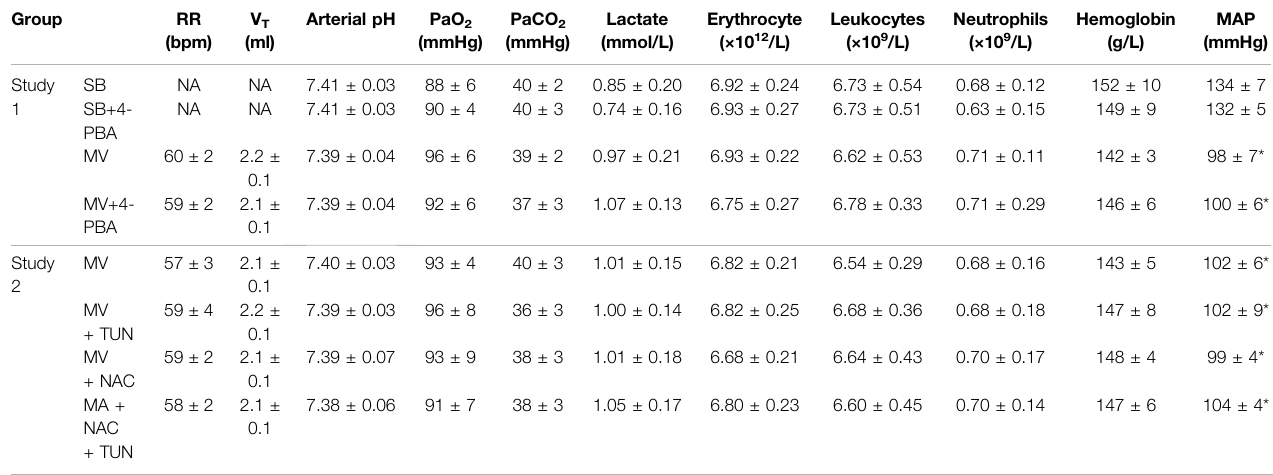
TABLE 1 | Ventilator parameters and systemic